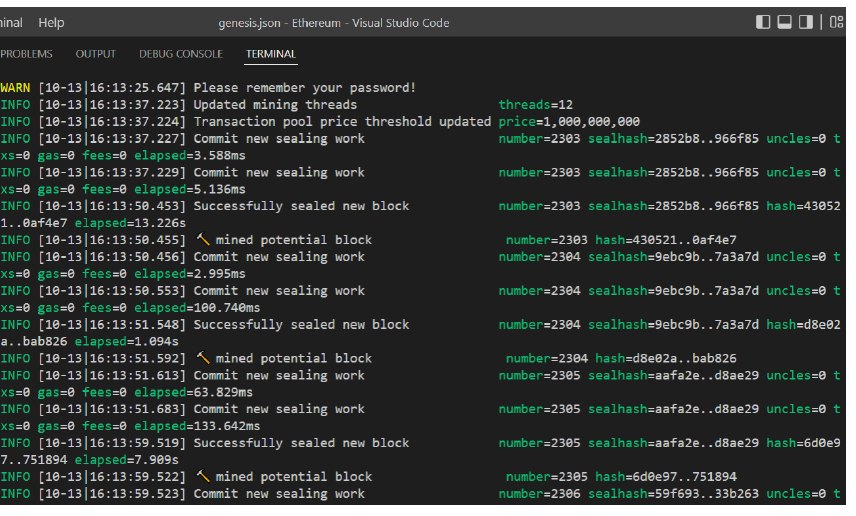
Figure 12. Mining